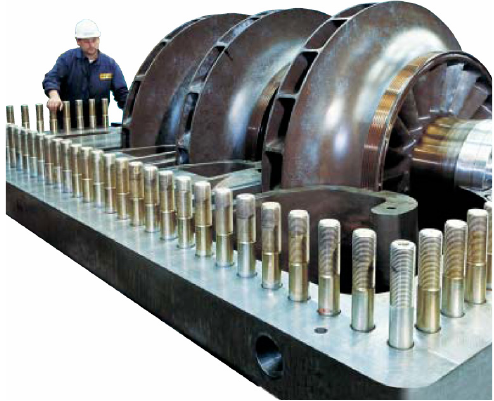
Figura 1: Tipiche dimensioni di un compressore centrifugo e relativa flangia bullonata di